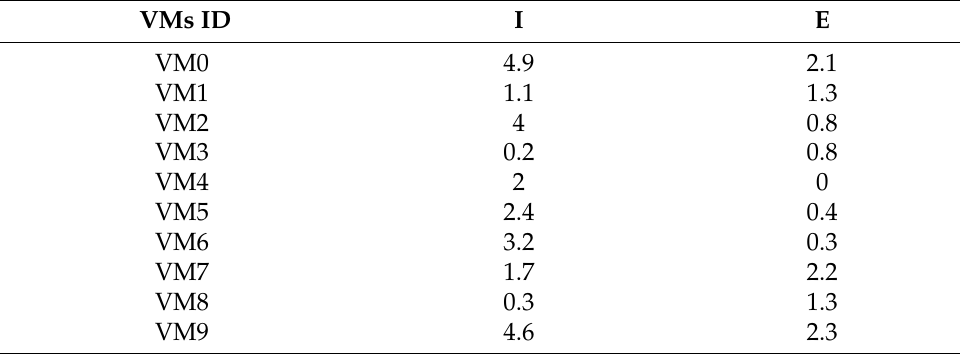
Figure 4. Federated cloud model example. Table 4. VMs exploitability (E) and impact (I) in side-channel